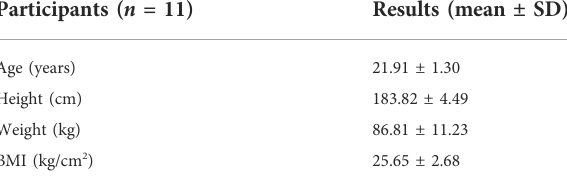
TABLE 1 Baseline characteristic of subjects who completed all